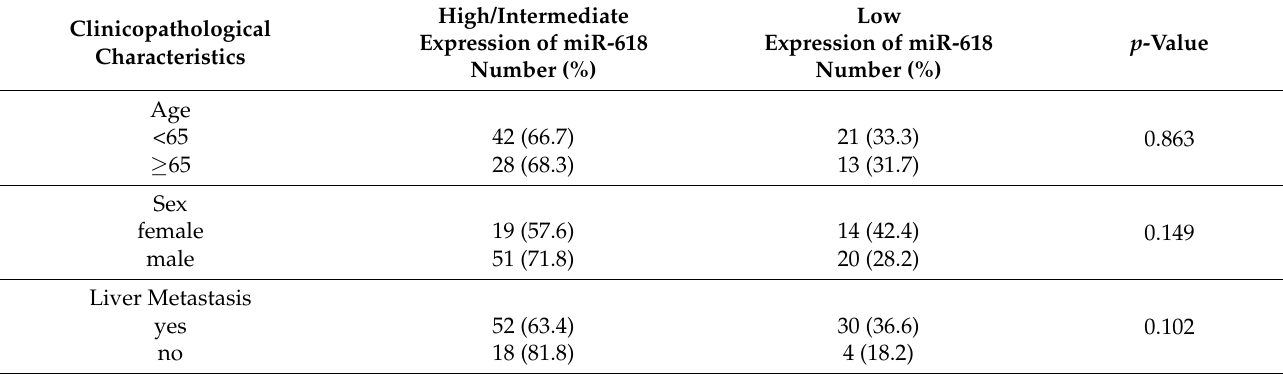
Table 1. Relations between miR-618 expression and clinicopathological characteristics of the mCC patients. Clinicopathological